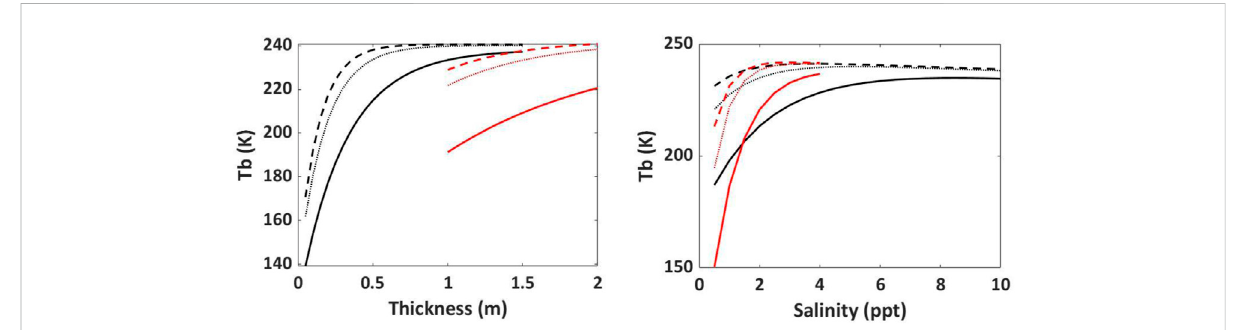
FIGURE 6 SeaicemodelsofT B forconstantsalinity(6psu)asafunctionoficethickness(left)andforconstantthickness(1 m)asafunctionofsalinity(right). Black curves represent fi rst year ice and red curves represent multiyear ice. Solid, dotted and dashed lines correspond to 0.5, 1.4 and 2.0 GHz frequencies respectively. The ice temperature is -10 C. The Vant et al. (1978) model of sea ice permittivity is used to calculate the